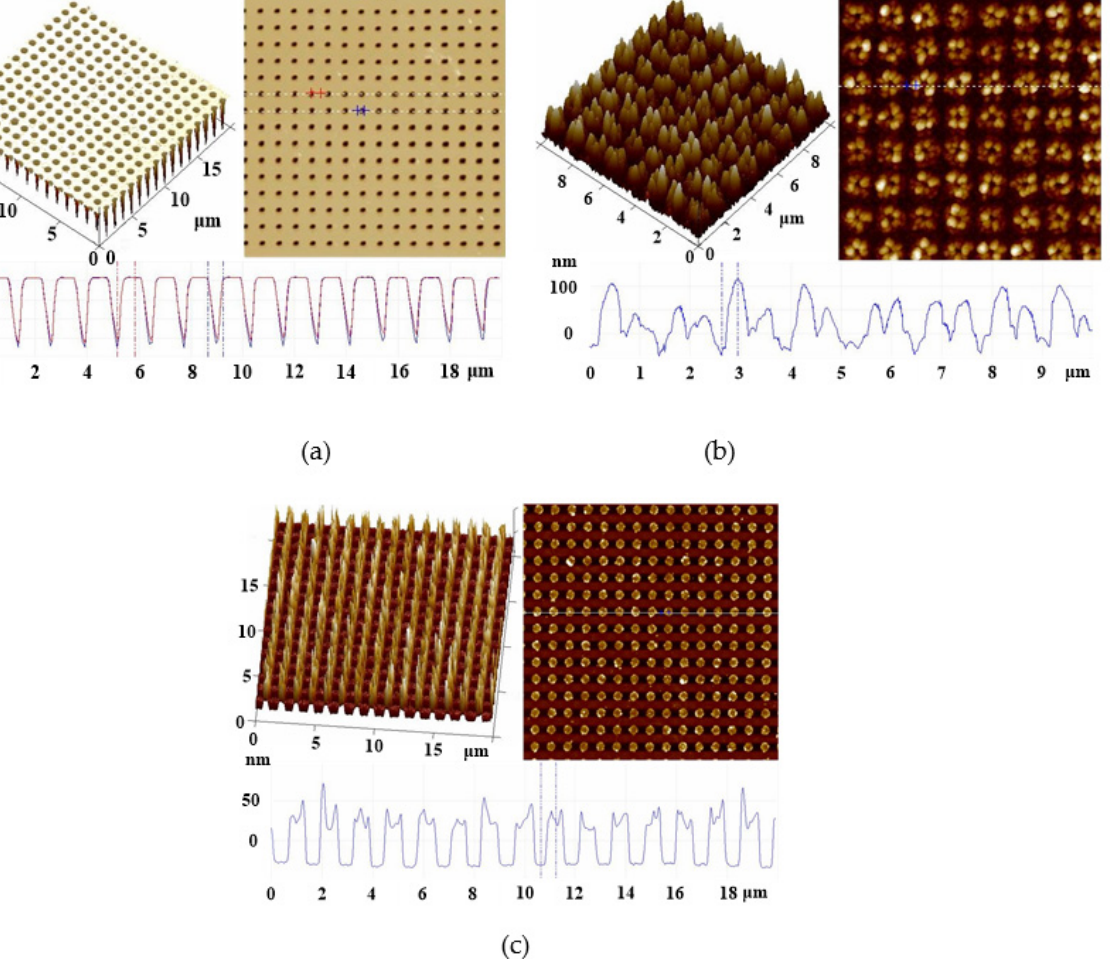
Figure 2. 2D and 3D AFM images and cross-section profiles of ( a ) bare hole array, ( b ) 500H-P(MAA- DB), and ( c ) 500H-P(MAA-DB)-BDA on the silicon substrate.